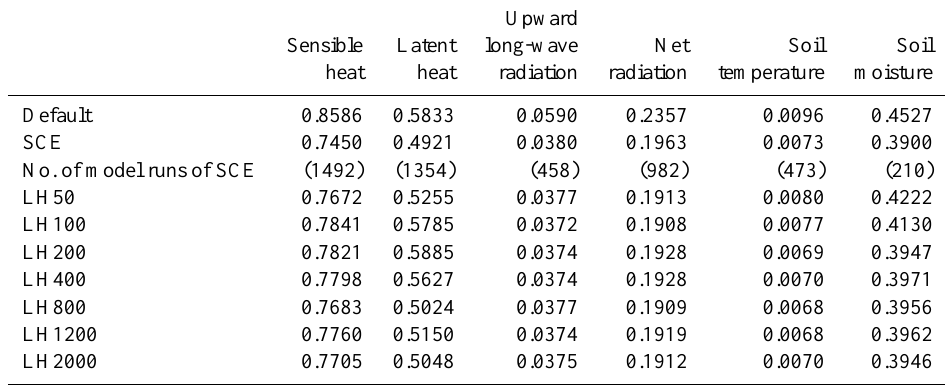
Table 3. The NRMSE between simulated and observed outputs after single-objective optimization. Upward Sensible Latent long-wave Net Soil Soil heat heat radiation radiation temperature moisture Default 0.8586